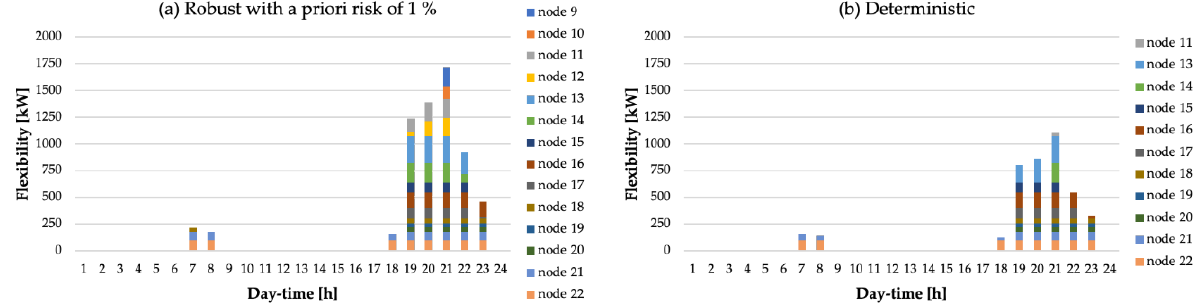
Figure 12. Requests of demand curtailment for ( a ) the robust solution with 1% of a priori risk and ( b ) the deterministic solution.